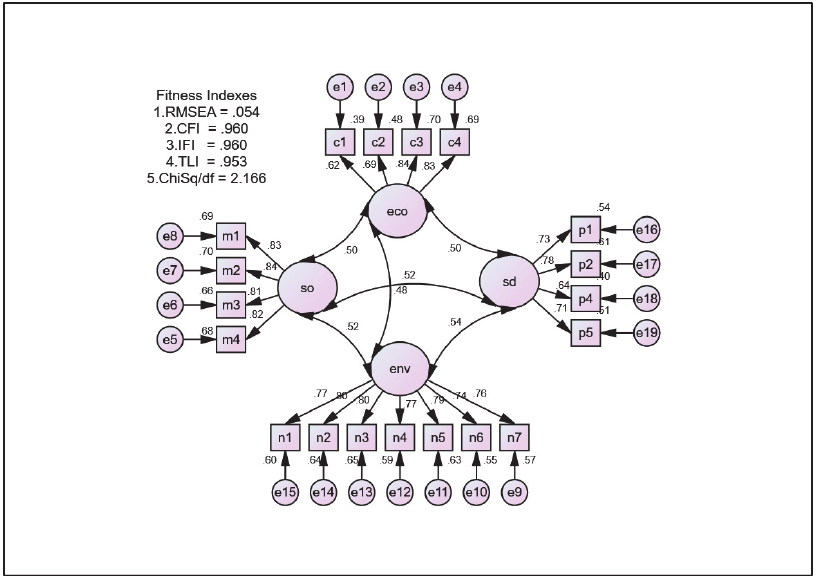
Fig. 2. Measurement model for sustainable